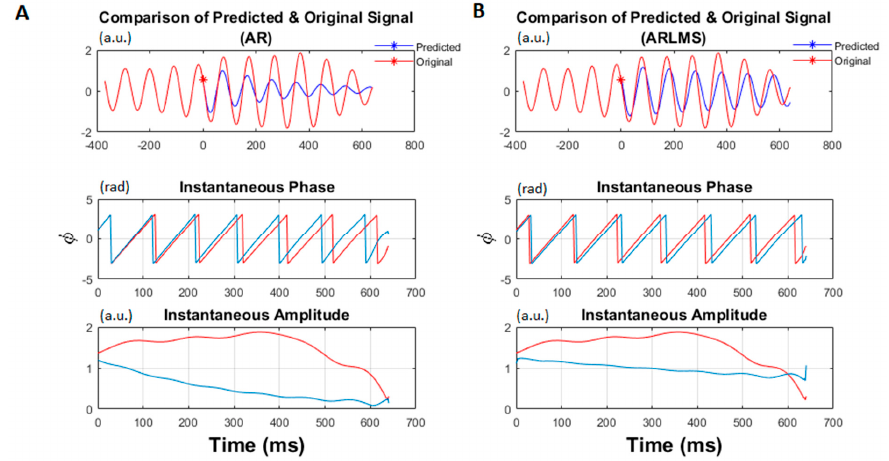
Figure 5. Representative prediction data of the AR model and the LMS-based AR model for double the prediction length (256 ms). Original data segment is shown as the red signal, while the predicted signal is shown in blue. ( A ) AR model and its respective instantaneous phase and amplitude; ( B ) LMS-based AR model and its corresponding instantaneous phase and amplitude. Asterisk (*) shows the prediction starting point.